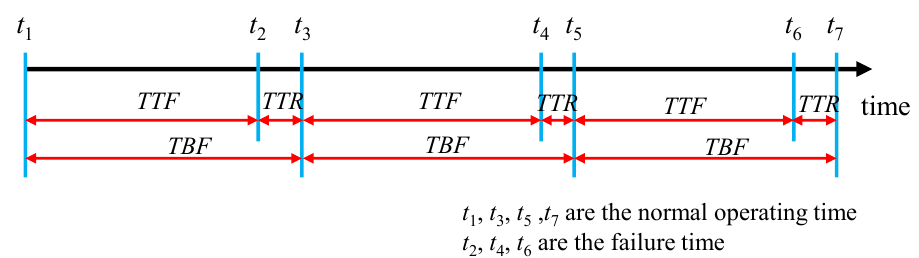
Figure 4. The schematic of the relationships between the TBF, TTR, and TTF. Table 3. The time to catastrophic failure T c of the compressor unit.